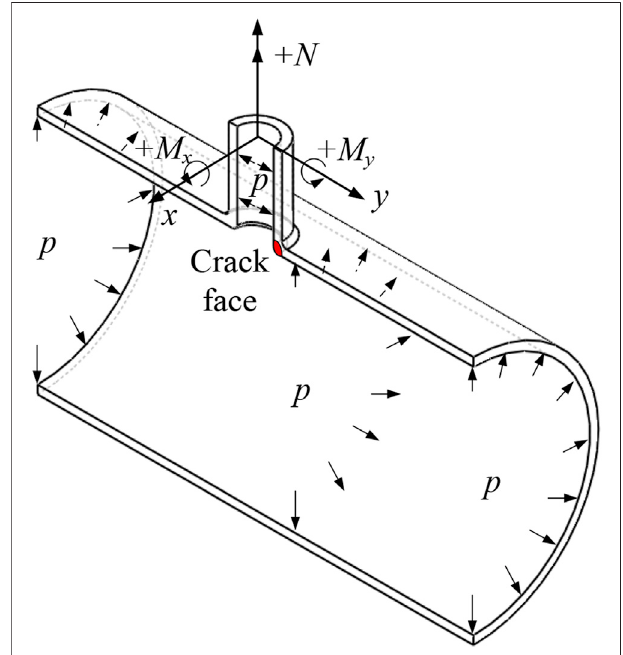
FIGURE 6 | Loading